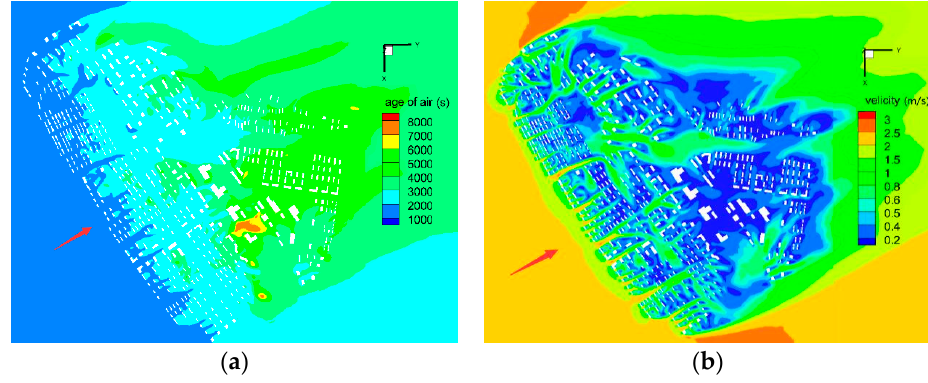
Figure 11. Stagnation of air in the Southern New City region in summer: ( a ) Age of air; ( b ) Airflow velocity.